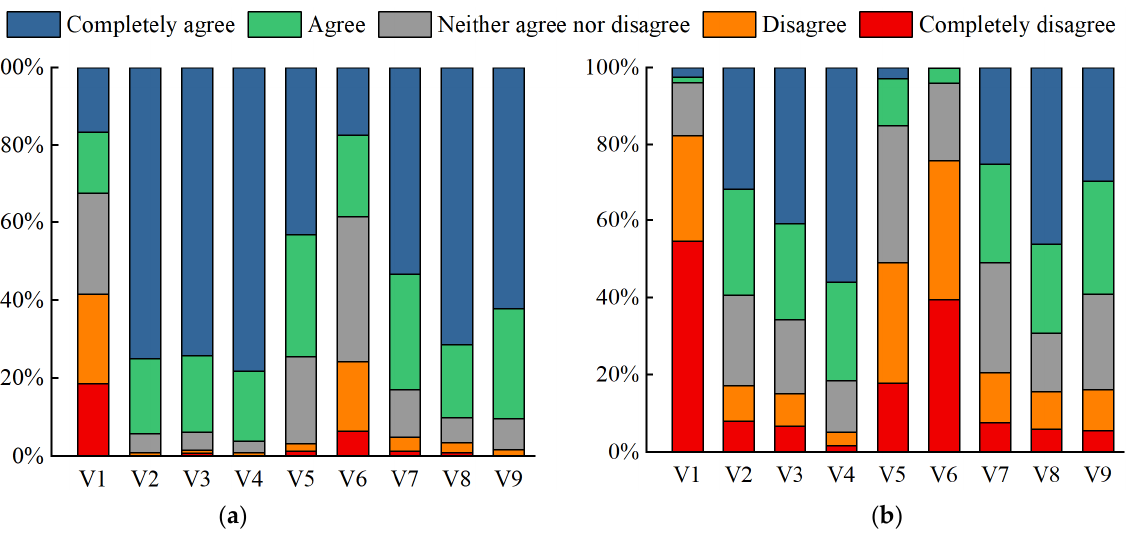
Figure 6. The conditional probability within two latent classes. ( a ) Class 1: shared-mobility optimists. ( b ) Class 2: shared-mobility pessimists.